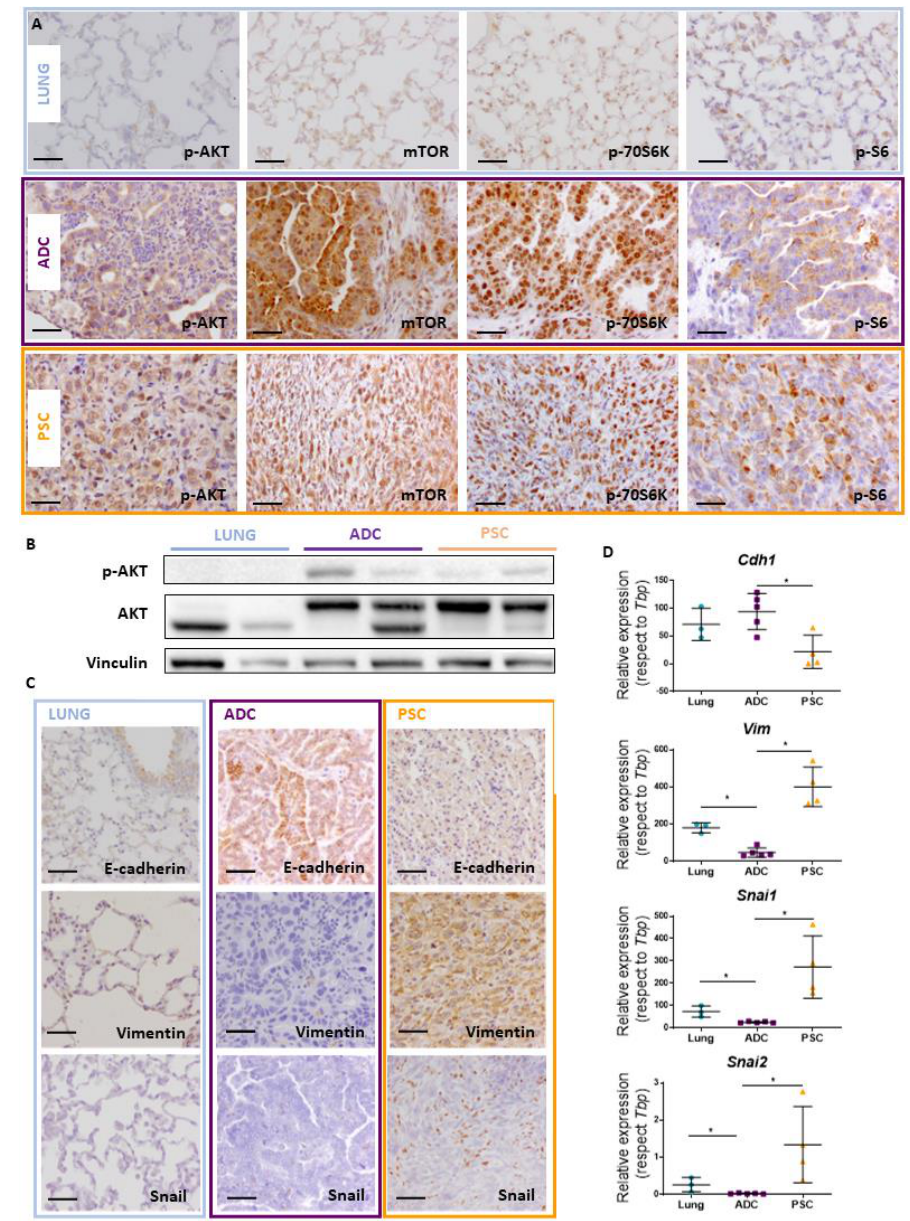
Figure 4. Akt pathway activity and EMT process in adenocarcinoma (ADC) and pulmonary sar- comatoid carcinoma (PSC) arisen in DKO mice . ( A ) Sections from lungs (upper panel), ADC (mid- dle panel) and PSC (lower panel) were immunostained for p-Akt, mTOR, p70S6K and pS6, as indi- cated. Bars = 50 µm. ( B ) p-AKT and AKT were assessed using Western blotting analyses. Original image of western blot can be found at File S1 ( C ) Immunohistochemical analyses for the quoted proteins (E-cadherin, Vimentin and Snail) involved in the EMT processes in lungs (left column), ADC (middle column) and PSC (right column). Bars = 50 µm. ( D ) qRT-PCR analysis of Cdh1 , Vim , Snai1 and Snai2 (encoding for E-cadherin, Vimentin, Snail and Slug, respectively) expression levels in ADC, PSC and control lungs. * p < 0.05, determined by